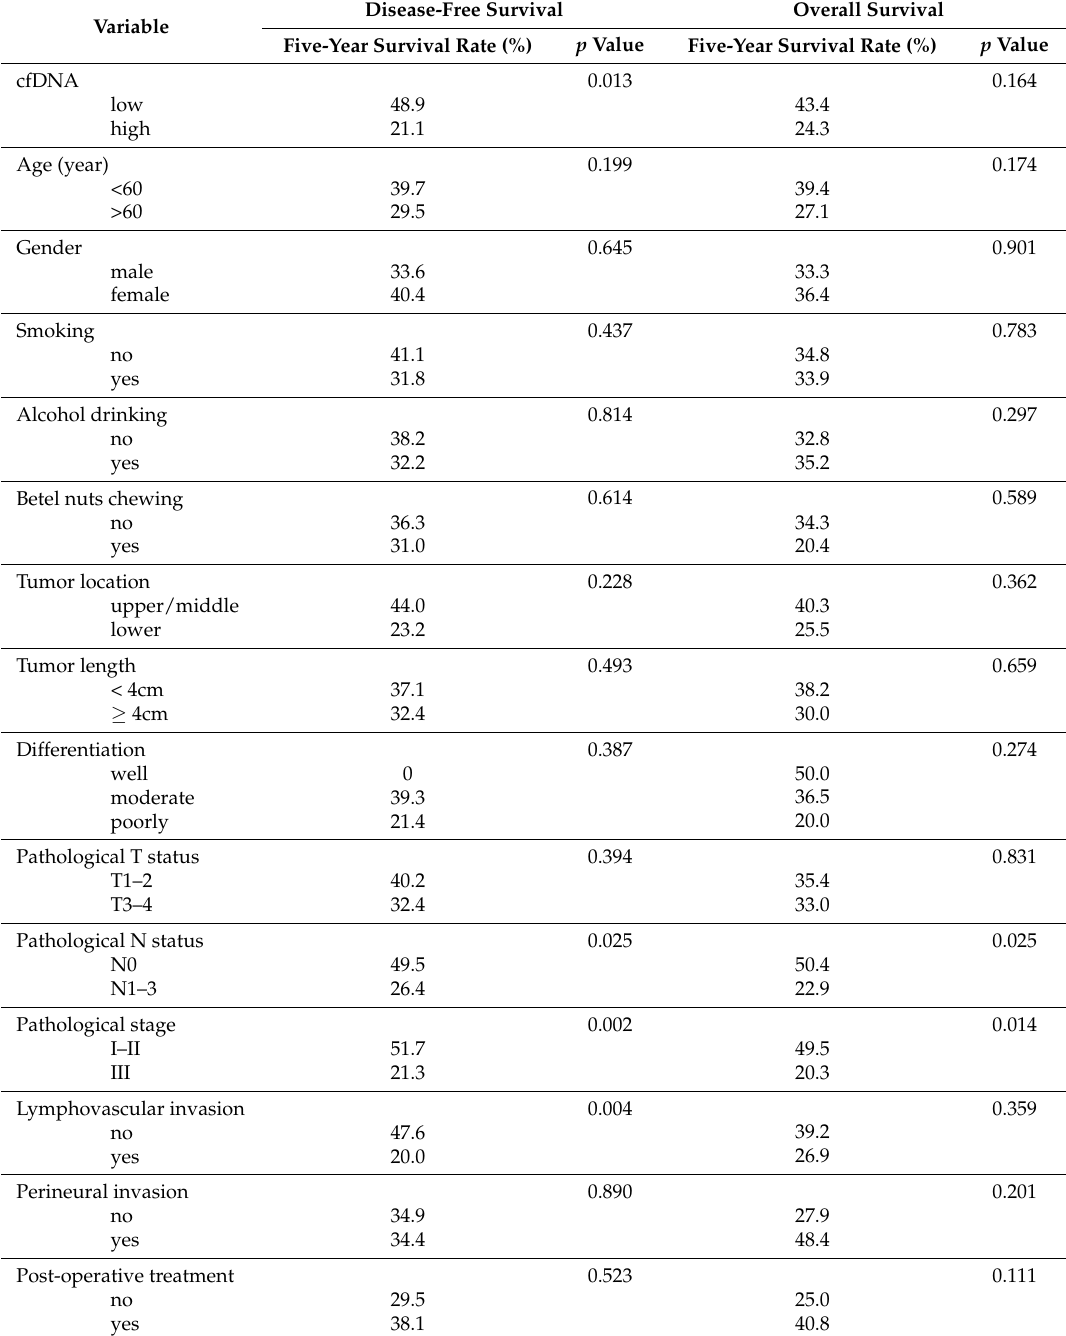
Table 2. Survival analysis of prognostic factors influencing disease-free survival and overall survival after